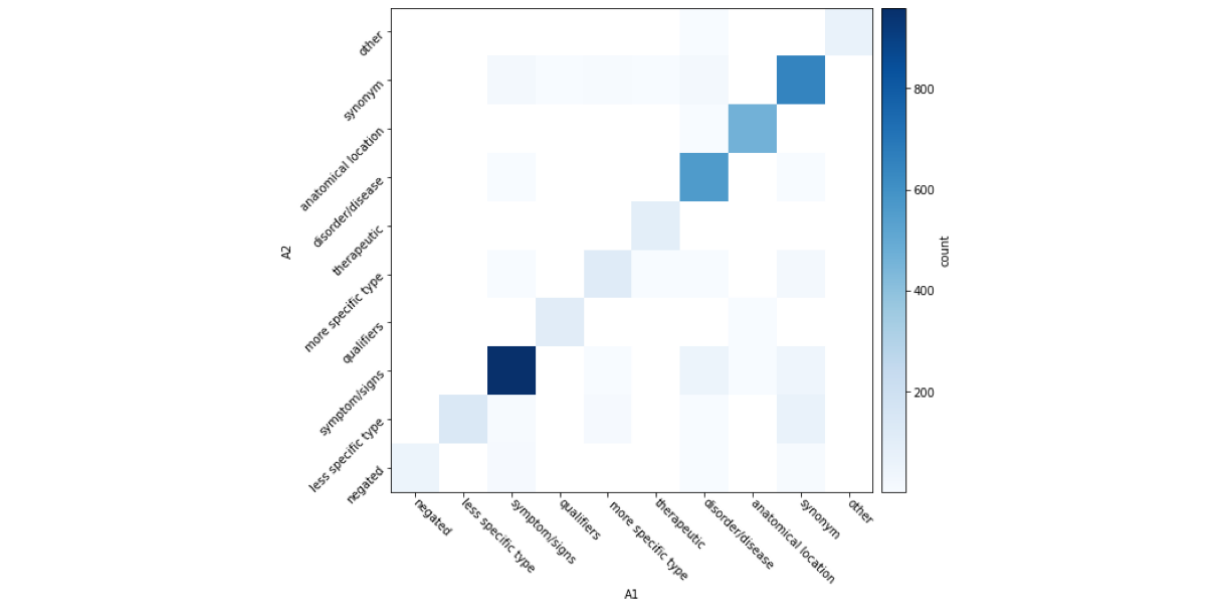
Figure 2. A1/A2 interannotator agreement of returned terms according to semantic type.